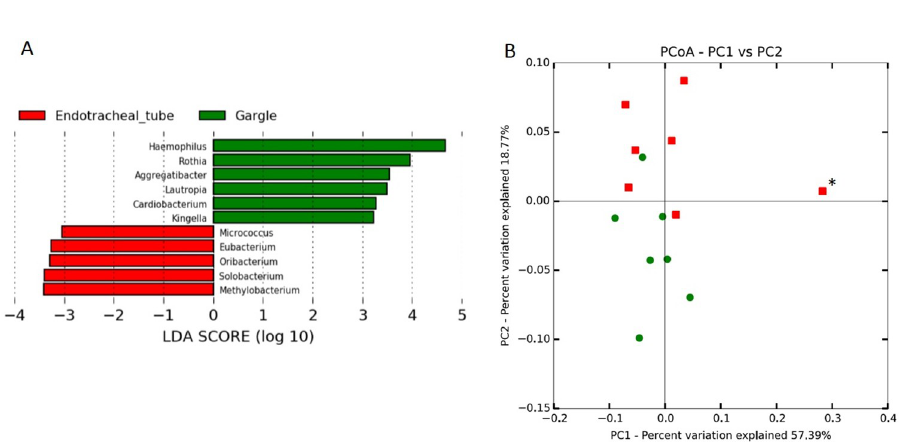
Fig 2. Comparison between ET washings and oral gargles. (A) Comparison of relative abundance of genera between ET washings (red) and oral gargles (green). The 11 genus level OTUs gave linear discriminant analysis (LDA) values > 2. (B) PCA plot for ET washings (red) and oral gargles (green). � indicates sample HC02.